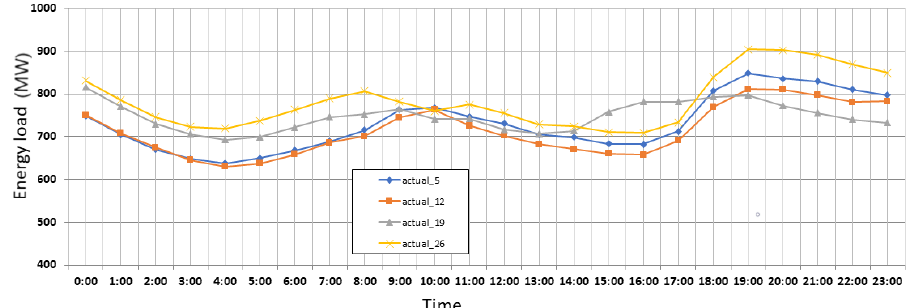
Figure 6. Energy consumption on Saturdays of January 2019.